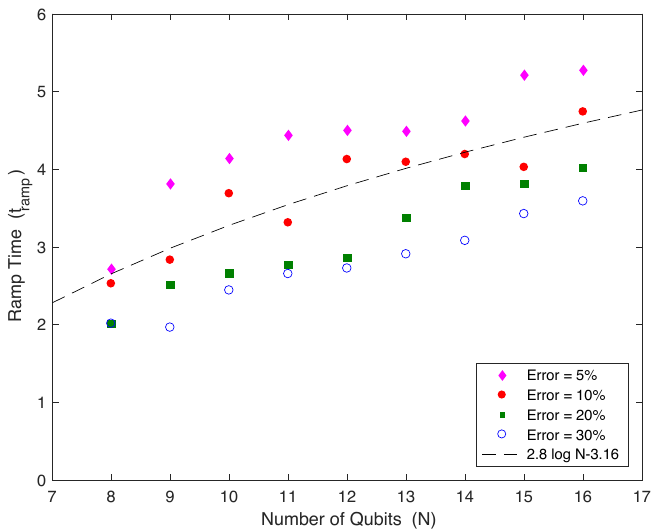
Figure 8 . We plot the estimate of t ramp for di(cid:11)erent N and di(cid:11)erent choices of fraction errors. The dashed line is the t ( N ) = A log N + B (cid:12)t to the red dots. We (cid:12)nd that the best (cid:12)t for ( (cid:15) = 10 %) is given by t ramp = 2 : 8 log N (cid:0) 3 :